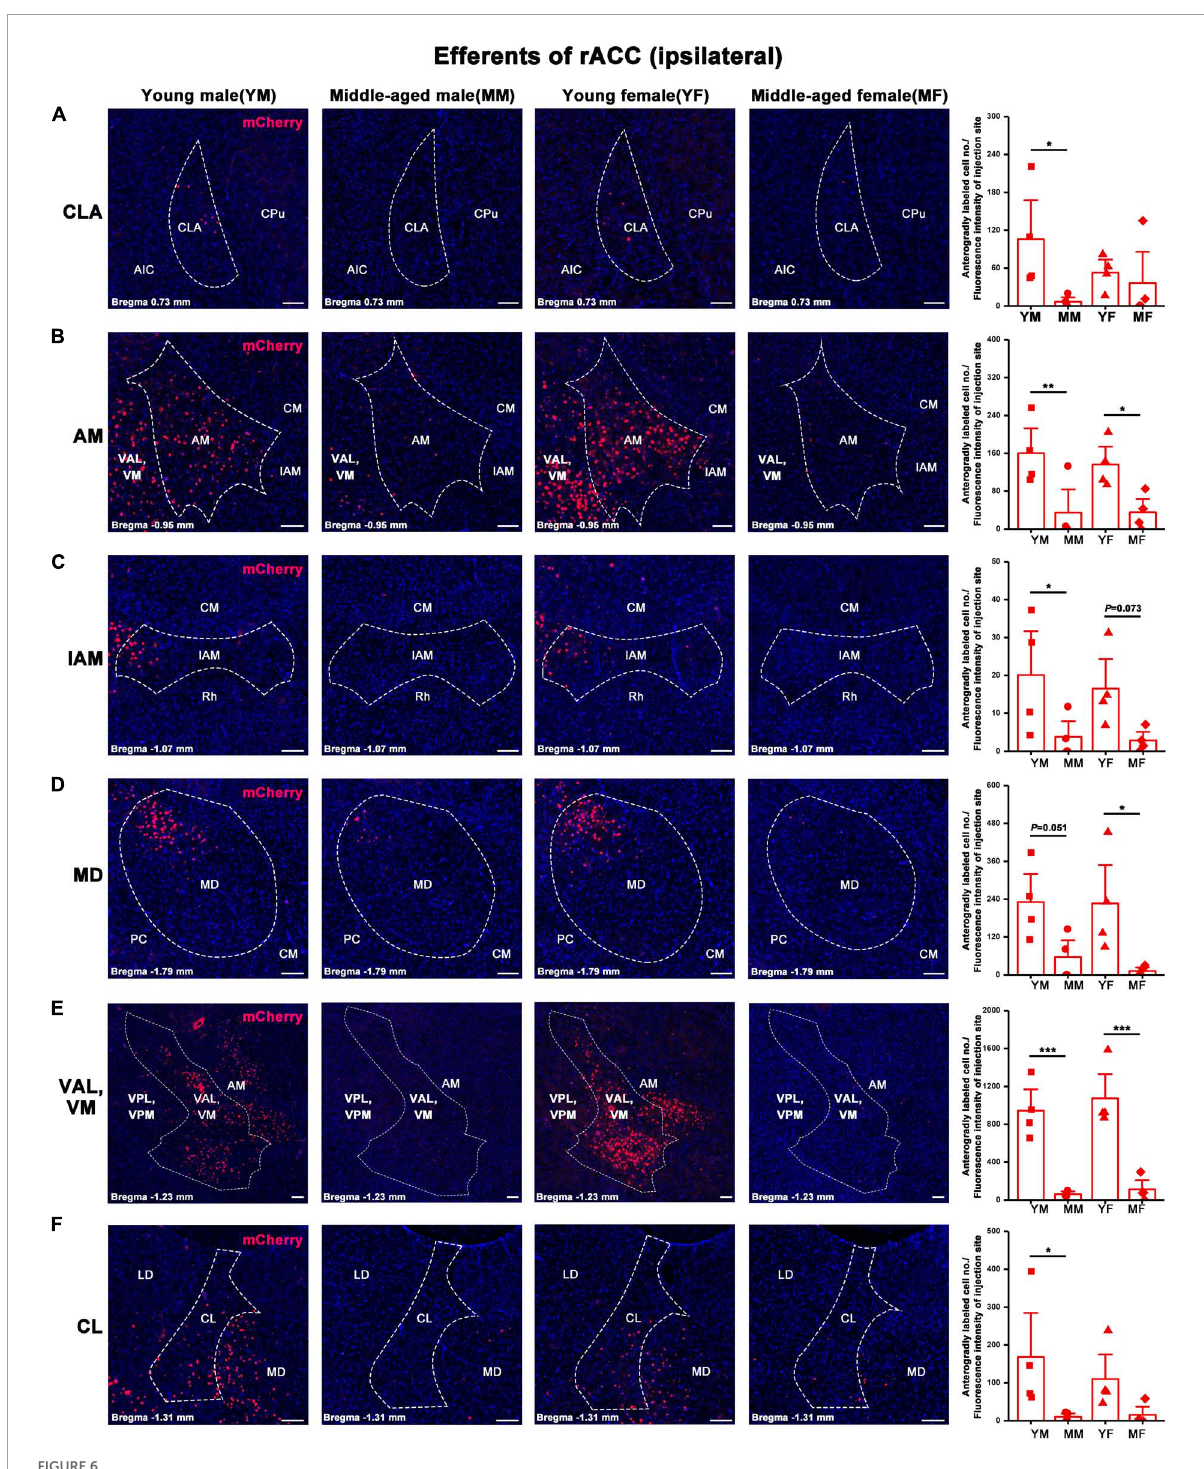
FIGURE6 Ipsilateral brain regions with anterograde projections of the rACC in mice of different ages and sexes. (A–F) Left: Representative images of anterogradely labeled neurons in the CLA, AM, IAM, MD, VAL, VM, and CL regions of young male, middle-aged male, young female, and middle-aged female mice. Right: Anterogradely labeled cell number divided by fluorescence intensity of injection site ( n = 4 young males, n = 4 middle-aged males, n = 4 young females, n = 4 middle-aged females).* p < 0.05, ** p < 0.01, *** p < 0.001. Scale bar = 100 µ m. Error bars represent